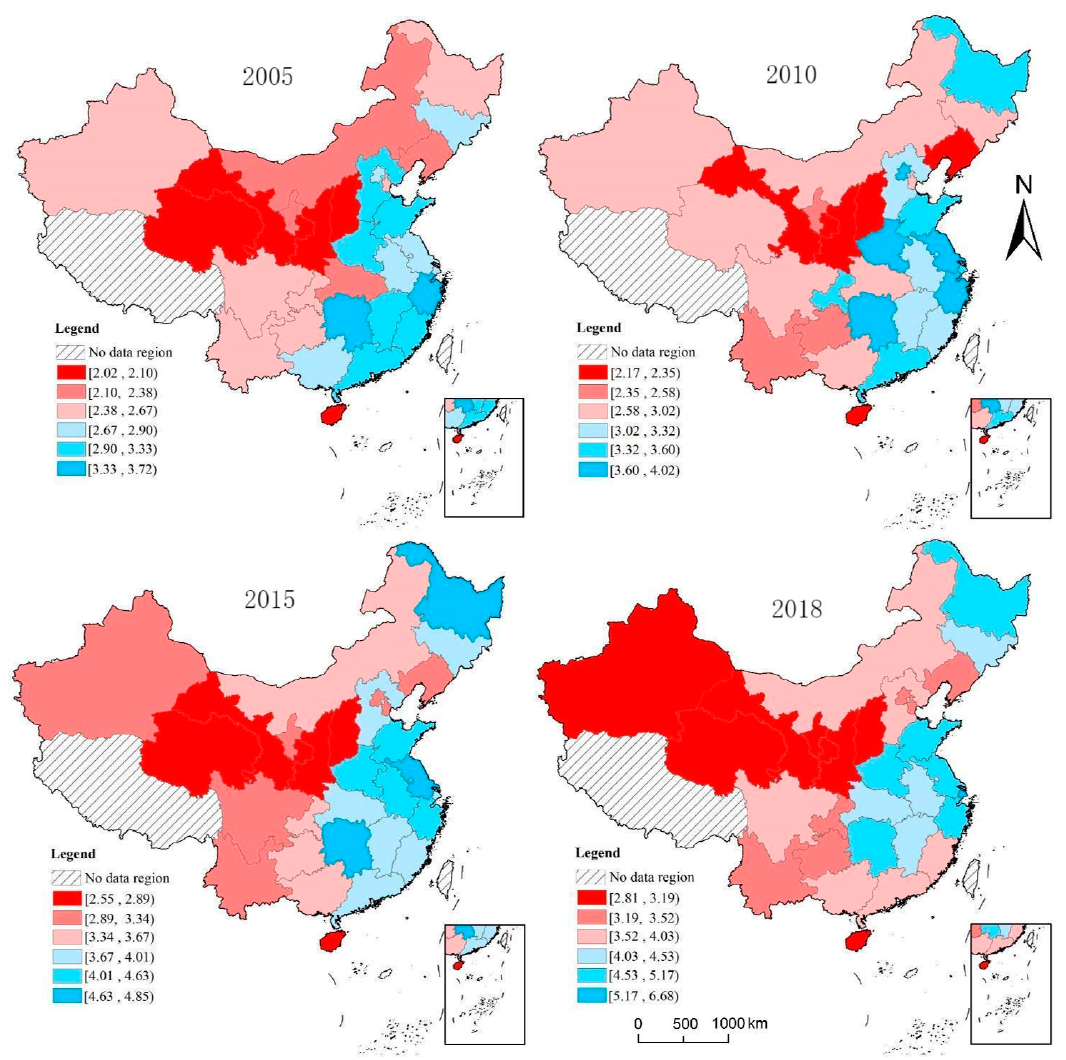
Figure 3. Spatio-temporal patterns of cultivated land use system resilience (CLSR) in some areas of mainland